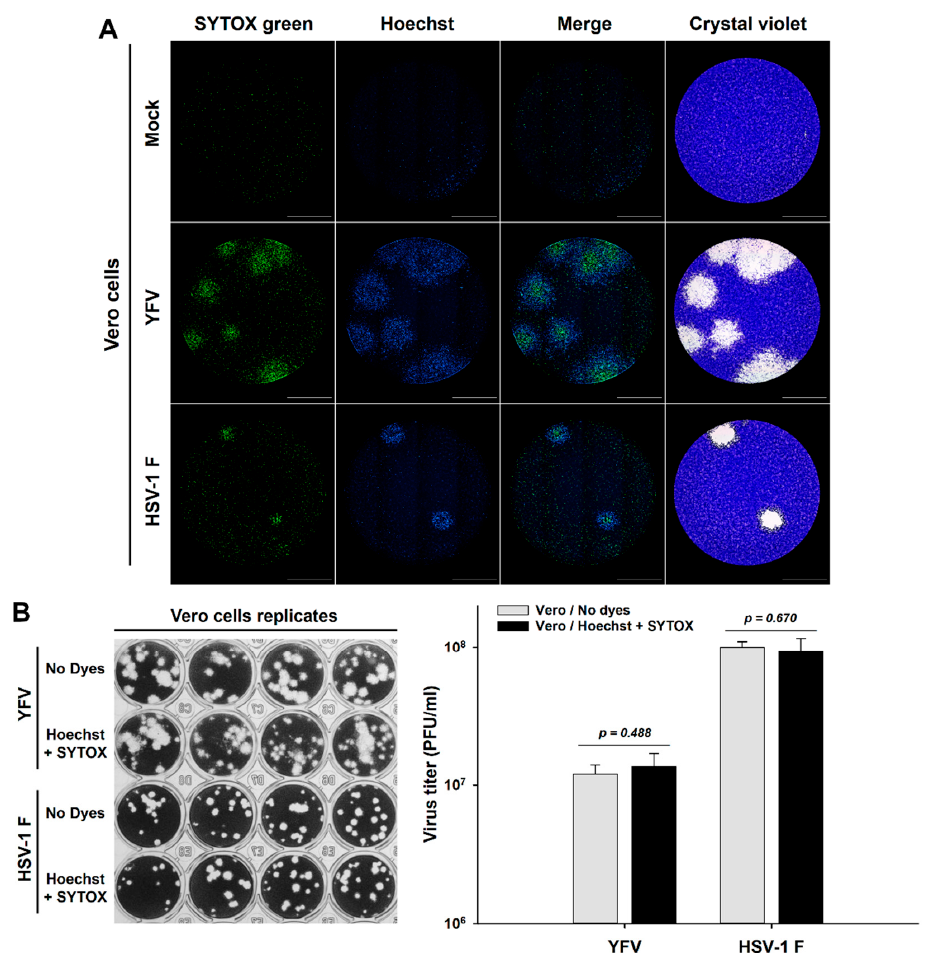
Figure 2. Labeling of virus-induced cytopathic effect with DNA fluorescent dyes has no effect on the replication of RNA and DNA animal viruses. ( A ) Vero cells were inoculated with either YFV or HSV-1 F seeds, cell nuclei were Hoechst stained, and cells were subjected to plaque assay during 120 h with a medium containing the cell death staining SYTOX Green. After live-cell imaging acquisition, viral plaques were confirmed by the standard crystal violet staining. ( B ) Vero cells were inoculated with either YFV or HSV-1 F seeds and subjected to plaque assay for 120 h both in the presence or absence of the DNA fluorescent dyes Hoechst and SYTOX Green. Plaques were revealed and counted using the standard crystal violet staining for the calculation of viral titers. A representative experiment is shown in each panel (n = three independent experiments), total magnification of 40X, scale bar = 2000 µm.